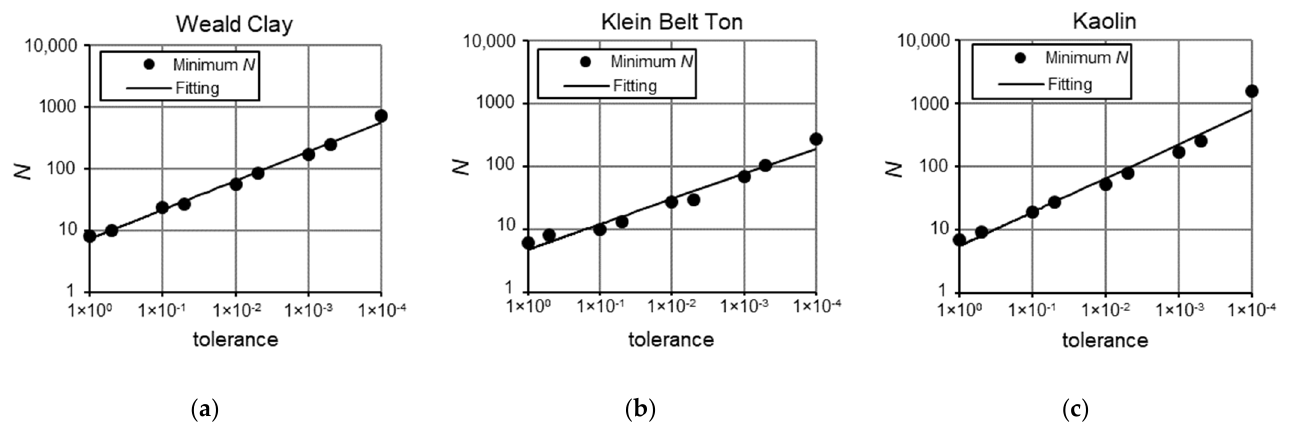
Figure 6. Ratio of elastic and plastic strain increments for the α paths defined in Figure 4 with respect to the number of computational steps for ( a ) Weald clay, ( b ) Klein Belt Ton, and ( c ) kaolin.